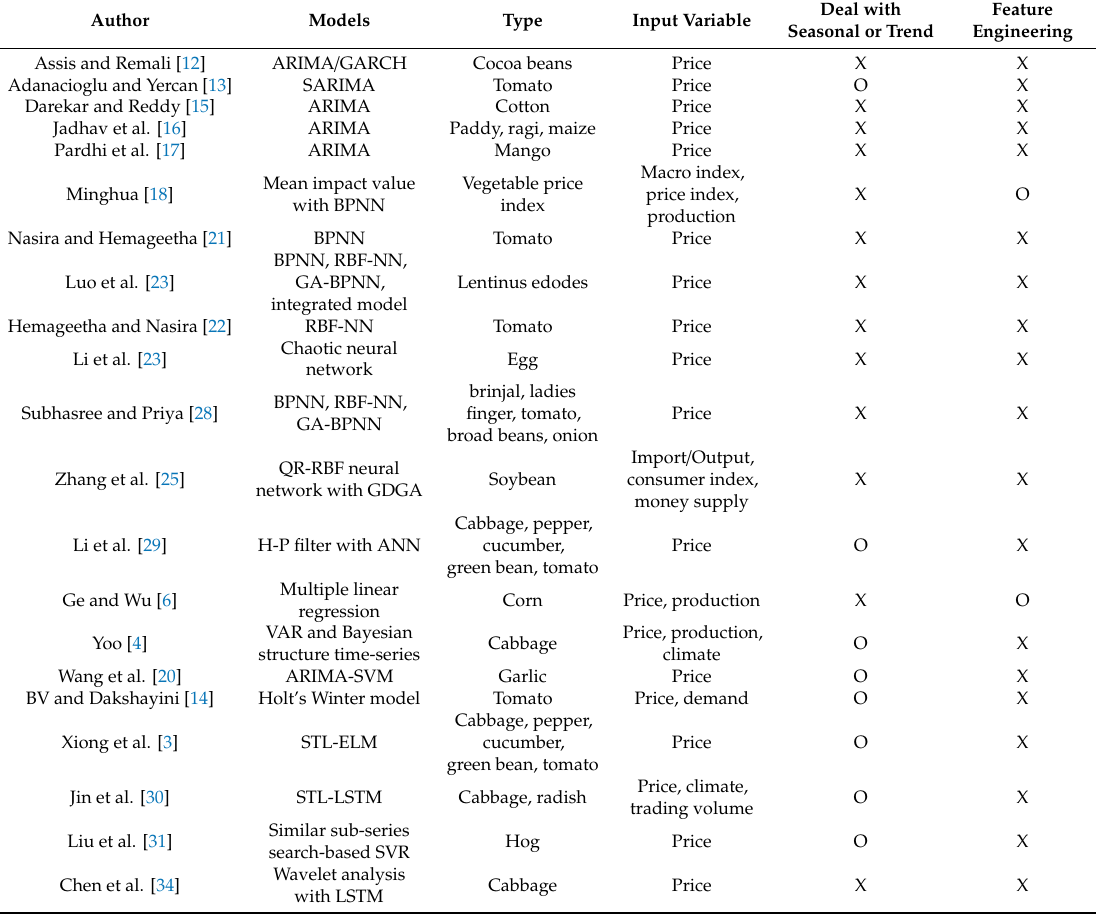
Table 1. Studies on agriculture commodity price